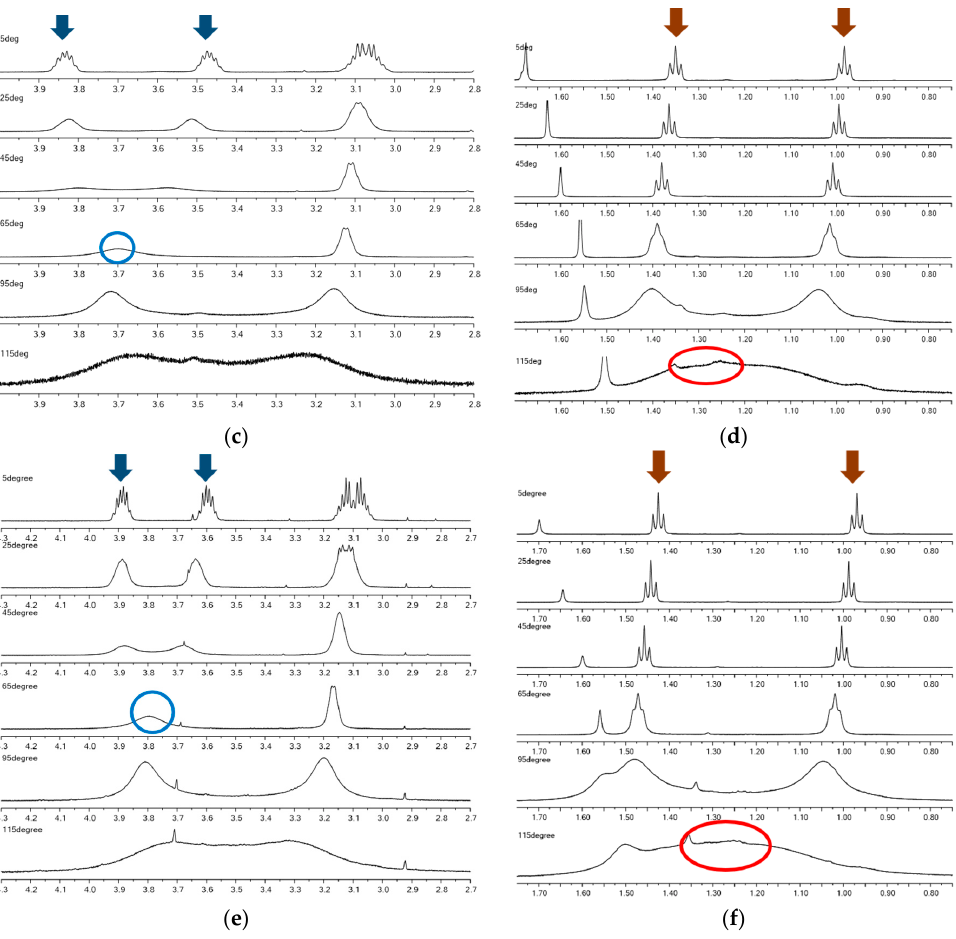
Figure 2. 1 H VT-NMR experiments on NCDEA and PCDEA. Arrows indicate each H and Me signal in each structure, and circles indicate the merged signals after the temperature increase. ( a ) Whole spectrum from NCDEA. Arrows indicate split H and Me signal and circles indicate the merged signal after the temperature increase. ( b ) Whole spectrum from PCDEA. Arrows indicate split H and Me signal and circles indicate the merged signal after the temperature increase. ( c ) H-H merges as temperature increases (NCDEA). ( d ) Me-Me merges as temperature increases (NCDEA). ( e ) H-H merges as temperature increases (PCDEA). ( f ) Me-Me merges as temperature increases